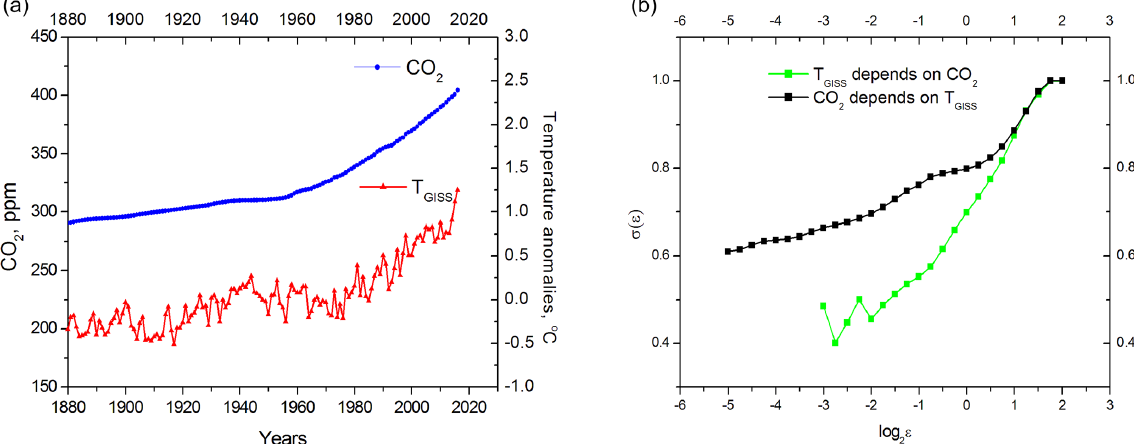
Figure 2. (a) GISTEMP (Hansen et al., 2006) surface temperature anomalies and atmospheric carbon dioxide concentration measurements (CO2 NASA GISS Data, 2016); (b) conditional dispersion of instrumental measurements. The black curve is the conditional dispersion of the carbon dioxide concentration. The green curve represents conditional dispersion of Northern Hemisphere temperature anomalies; its dependence on ε is much stronger than that of the black curve, indicating that carbon dioxide is the cause of temperature changes.